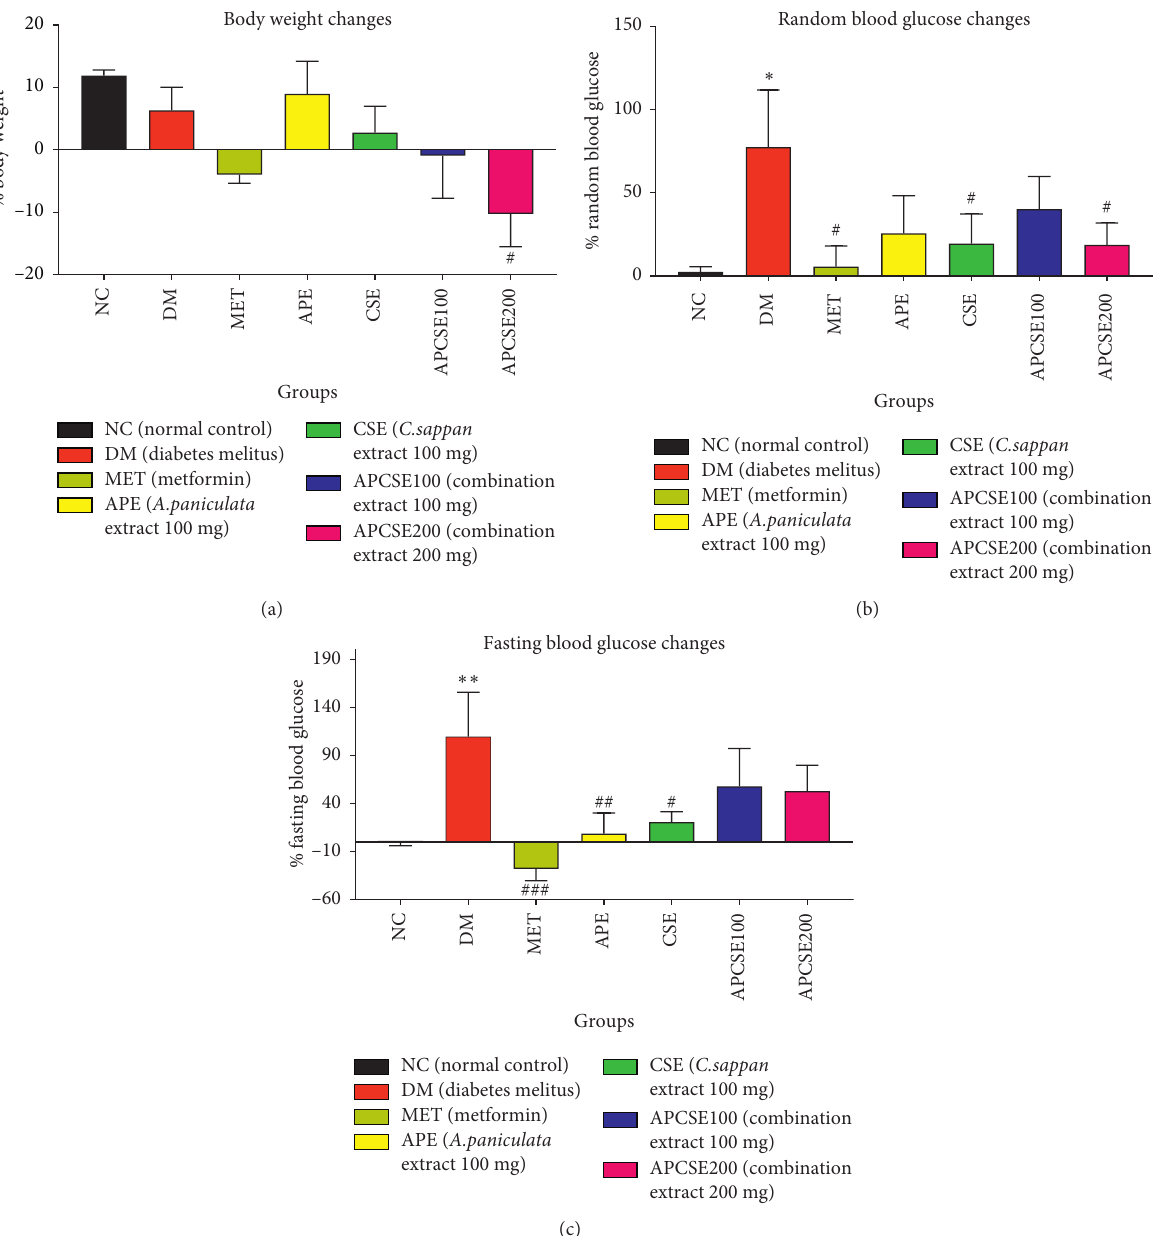
Figure 1: (a) Body weight changes, (b) random (nonfasting) blood glucose, and (c) fasting blood glucose. Changes in rats. The results are presented as the mean ± SEM ( n � 5). Significantly different from NC ( ∗ p < 0 . 05 ; ∗∗ p < 0 . 01 ) and significantly different from DM ( # p < 0 . 05 ; ## p < 0 . 01 )